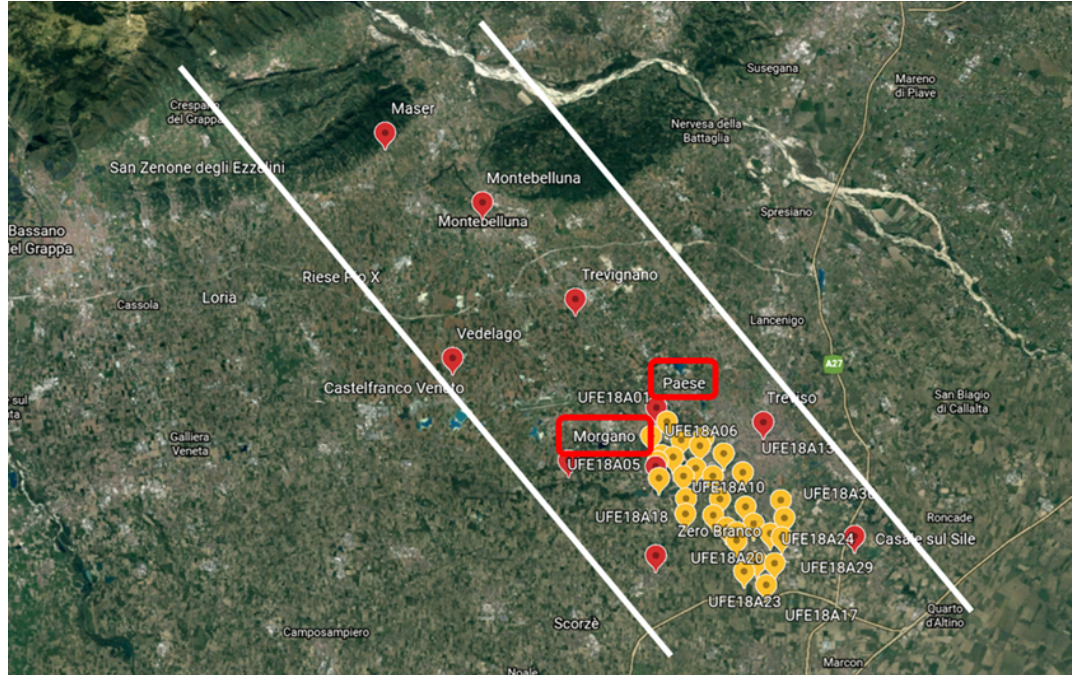
Figure 9. Map obtained by © Google Earth of the wells sampling site coloured in yellow and coloured in red the sampling area of the underground water analysed by ARPAV. Squared in red the towns of Paese and Morgano very closed to sampling analysed in this